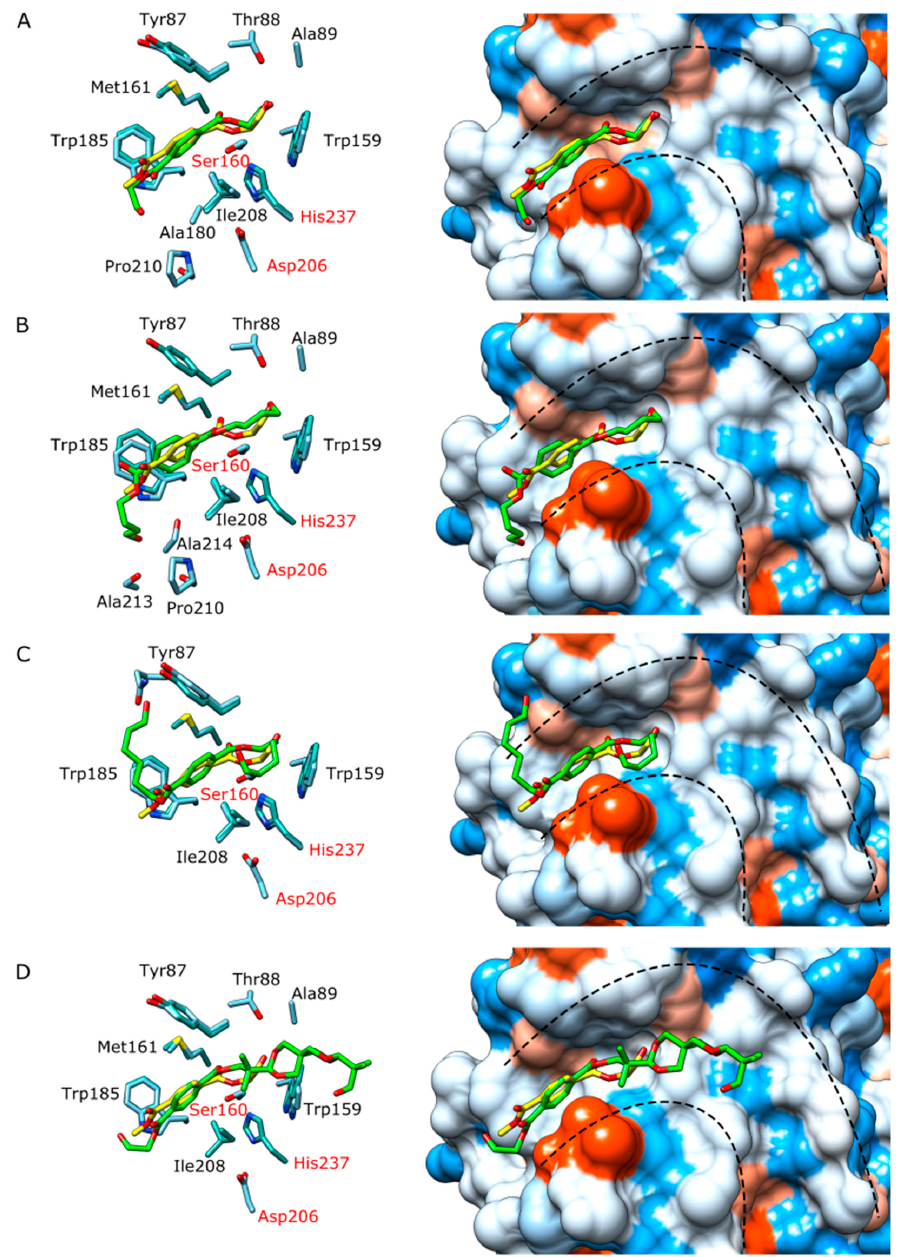
Figure 8. Docking of different ligands (represented in green) into Is PETase (in cyan) subsite I. The whole active site is indicated with segmented lines. The hydrophobicity surfaces of the active sites are represented according to the Kyte-Doolittle scale, ranging from dodger blue for the most hydrophilic to white and to orange-red for the most hydrophobic [57]. Every obtained enzyme/ligand complex is overlapped with the co-crystallized structure HEMT/double mutant Is PETase (5XH3), where the HEMT is represented in yellow and the mutant Is PETase is in light sea green. The catalytic amino acids are labeled in red. ( A ) BHET/ Is PETase. ( B ) BHBT/ Is PETase. ( C ) BHHT/ Is PETase. ( D ) Akestra TM fragment /Is PETase.